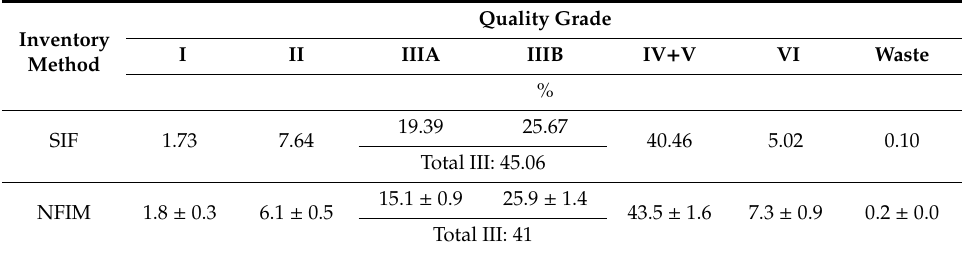
Table 2. Model distribution of broadleaved growing stock by quality grades of timber